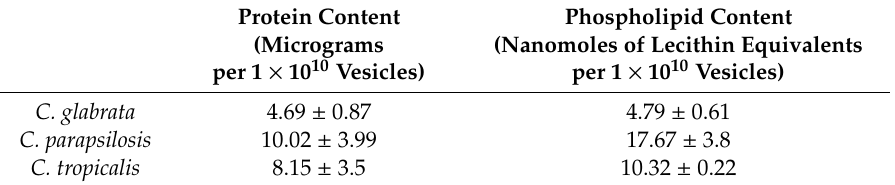
Table 1. Average protein and lipid contents in EVs obtained from C. glabrata , C. parapsilosis and C. tropicalis